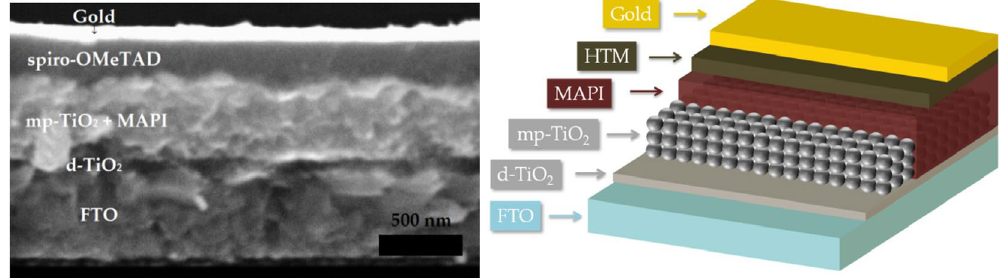
Figure 6. SEM cross section of a MAPI solar cell with spiro-OMeTAD as HTM (left). The scheme with the different layers present in the devices (right).